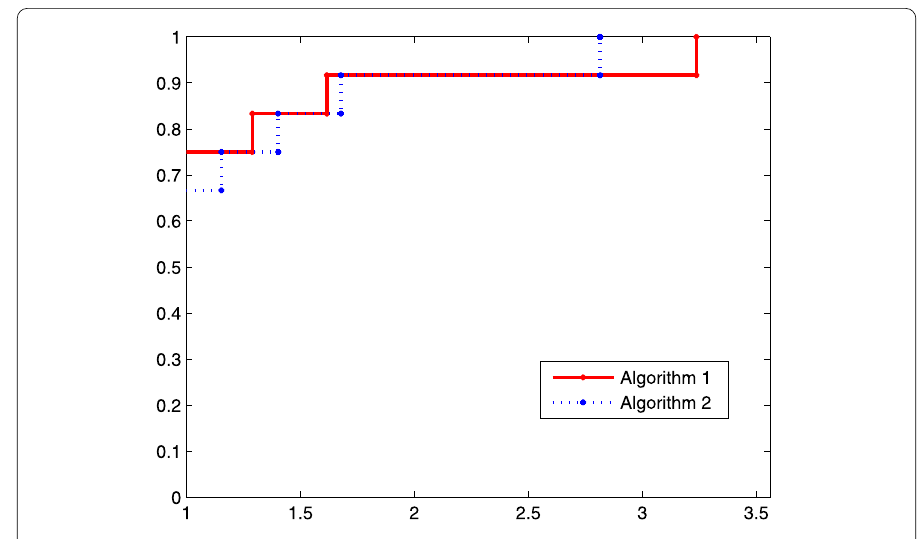
Figure 3 Performance profiles of the total number of iterations of two algorithms ( n = 10,000).